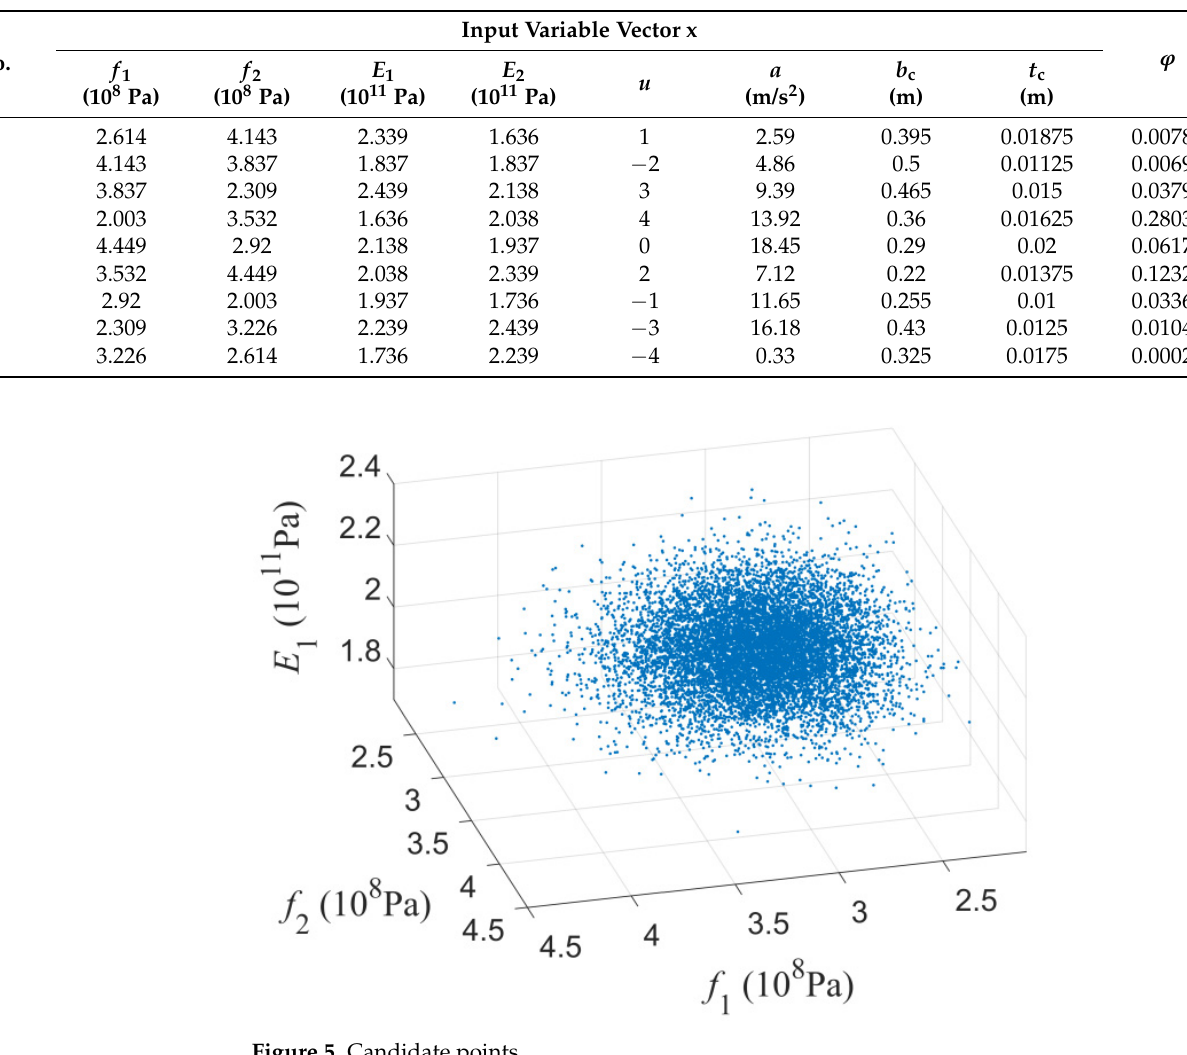
( d ) Figure 6. The response of the added samples in Example 1. ( a ) N I = 9. ( b ) N I = 3. ( c ) N I = 6. ( d ) N I = 17.